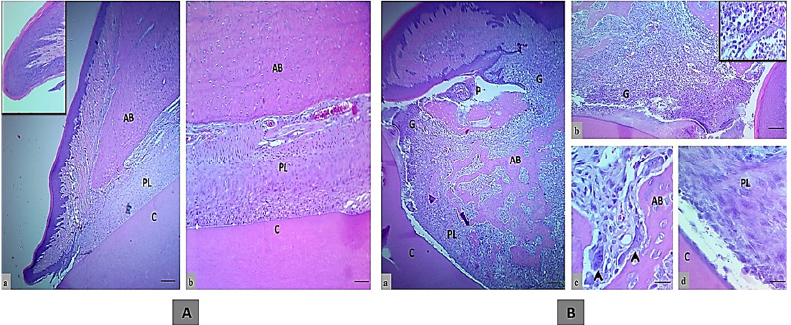
Figure 1. The histologic section of an incisor tooth and periodontal tissue of rats. ( A ) The control negative group, a and b. Normal histological and structural organization of the intact gingival lining epithelium and periodontal tissues (inset is normal histological features in low magnification), (H&E, scale bar 10 μm in section a and b). ( B ) Control positive group, a–c. Marked periodontal pocket (P) with disruption of the junctional epithelium and granulation tissue in the insertion point, also above the bone crest that indicated by G and inset, that showed the higher magnification of inflammatory cells infiltration, disorganized bone trabeculae (BT) and irregular bone surface with a presence of osteoclasts involved in bone matrix cavity (black arrows), d. The wide periodontal ligament space is filled with disorganized fiber and proliferating periodontal ligament tissue that has not attached to the cementum, (H&E, scale bar 10 μm in section a, and 20 μm in section b and 40 μm in section c and d). (AB; alveolar bone, PL; periodontal ligament and C; cementum).